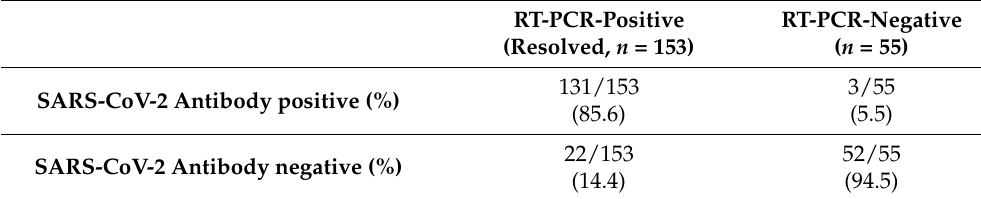
Table 2. Cross-sectional analysis of RT-PCR and SARS-CoV-2 Antibody Testing.